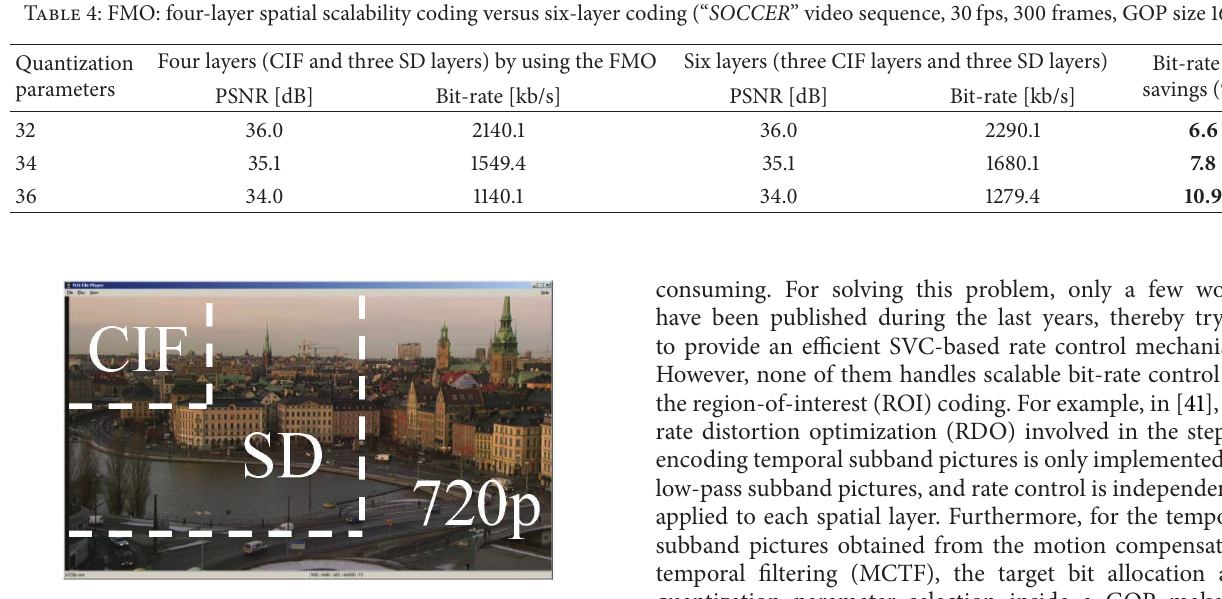
Figure 6: The 720p resolution frame of the “STOCKHOLM” video sequence, which presents two ROIs having CIF and SD